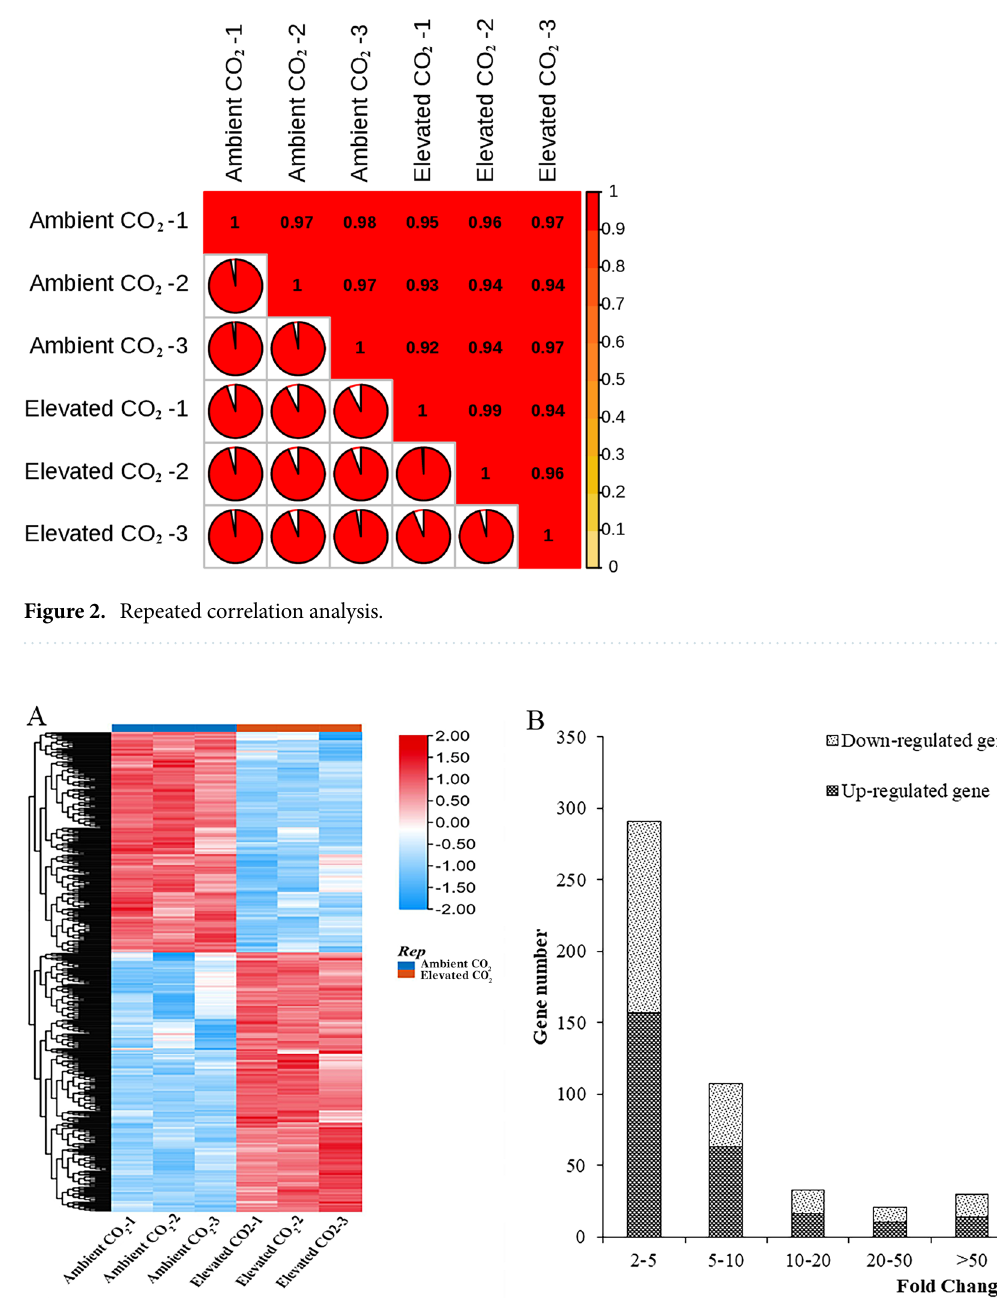
Figure 3. Statistical analysis of DEGs under CO 2 enrichment in carrot. A false discovery rate (FDR) value ≤ 0.01 and a FC value ≥ 2 were used as thresholds to identify significant